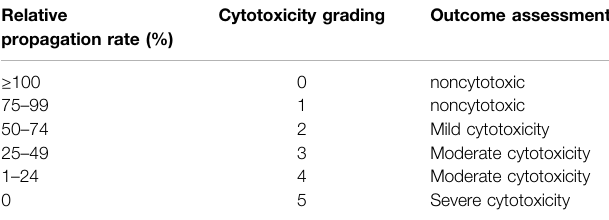
TABLE 2 | Cytotoxicity evaluation